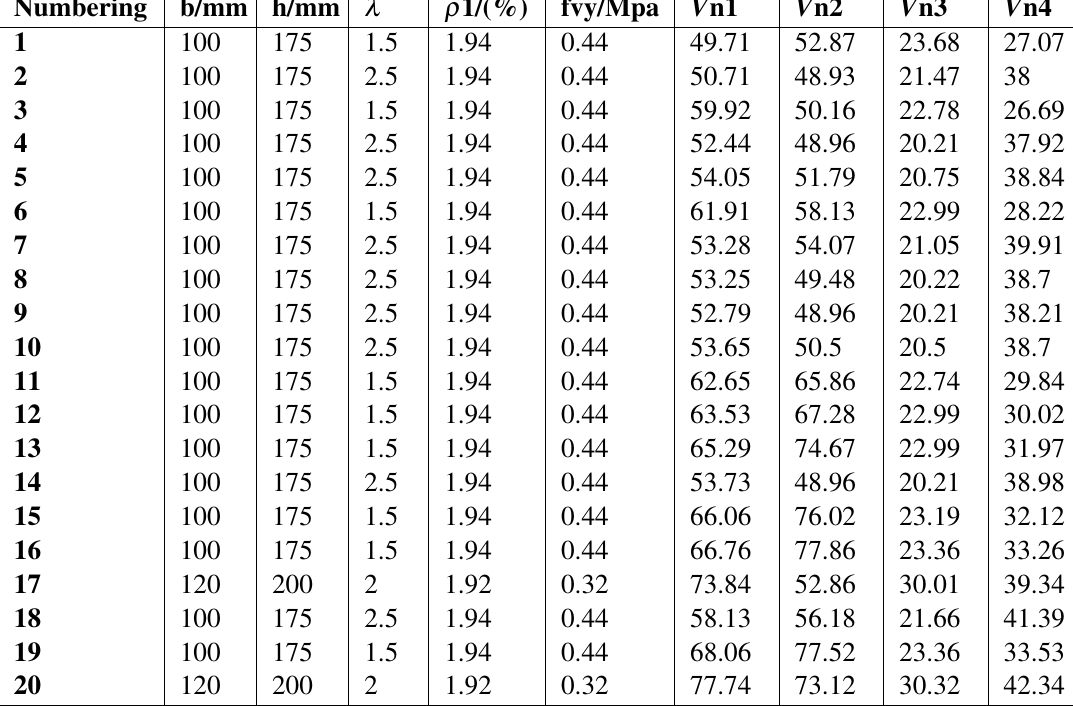
Table 1 Basic parameters of corroded RC beams and test values of shear capacity test